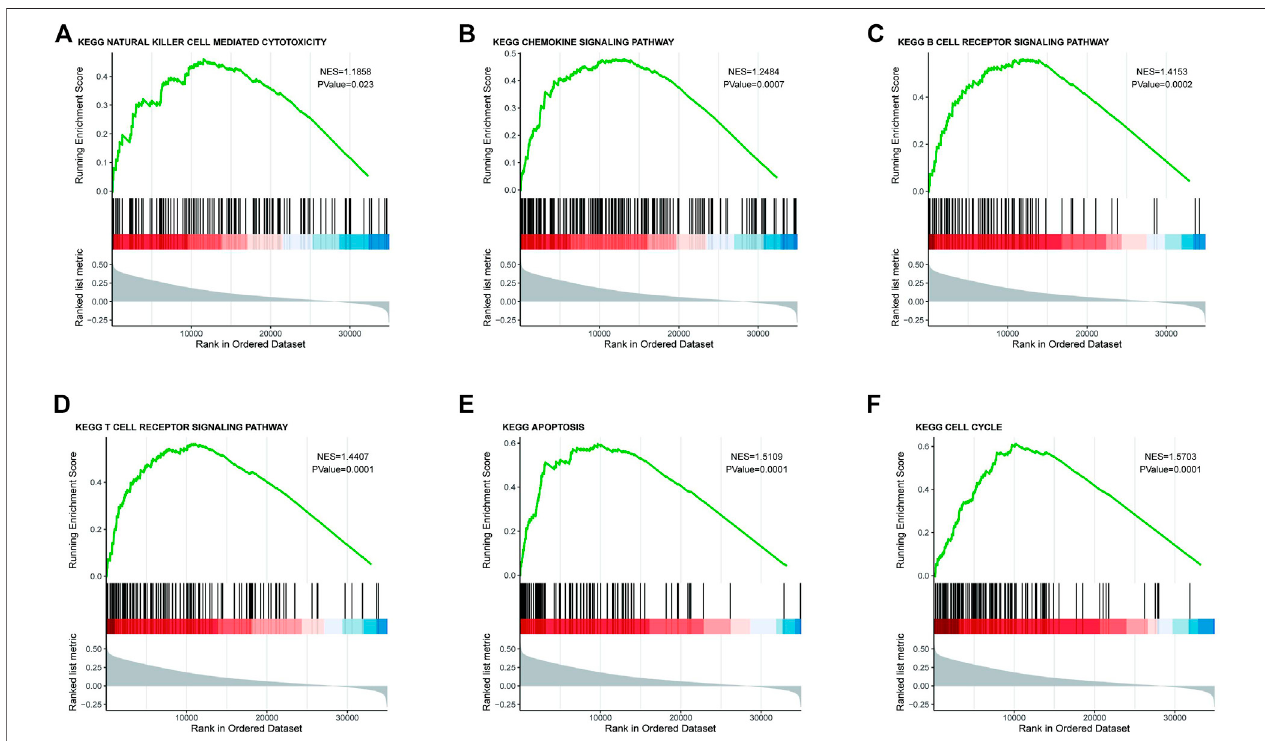
FIGURE 4 | Enrichment plots from the GSEA. GSEA results showing (A) natural killer cell – mediated cytotoxicity, (B) chemokine signaling pathway, (C) B cell receptor signaling pathway, (D) T cell receptor signaling pathway, (E) apoptosis, and (F) cell